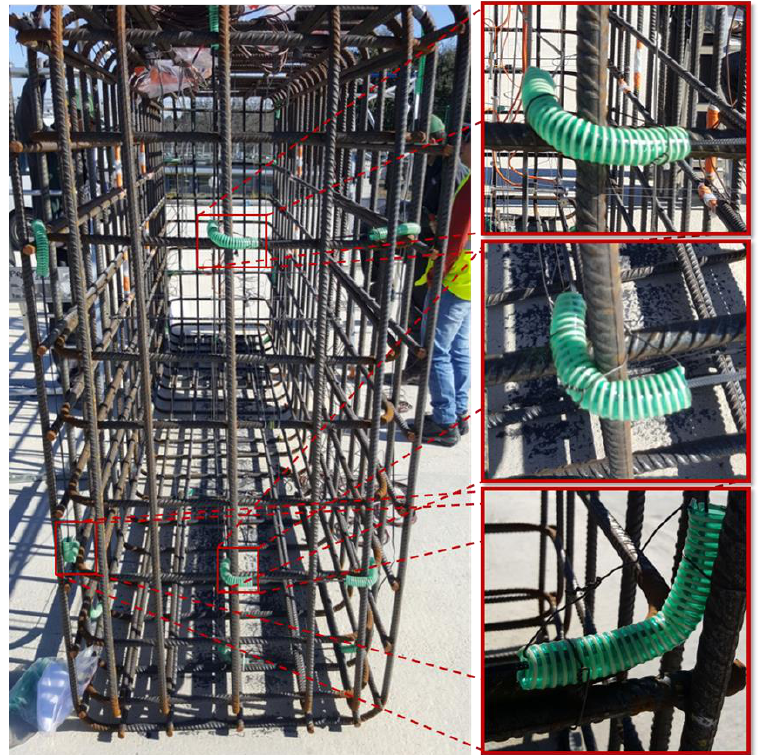
Figure 11. Instrumentation of block KB with embedded DOFS and details of cable bends around the stirrup (pictures on the right side). stirrup (pictures on the right